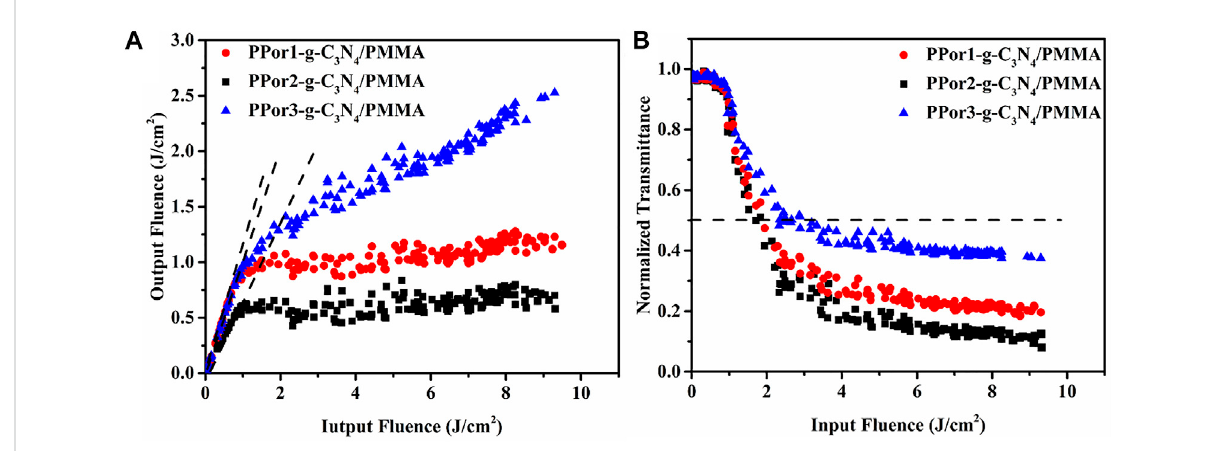
FIGURE 11 (A) The OL performance and (B) the non-linear transmittance of PPorx-g-C 3 N 4 /PMMA composites with the doping concentration of 0.05